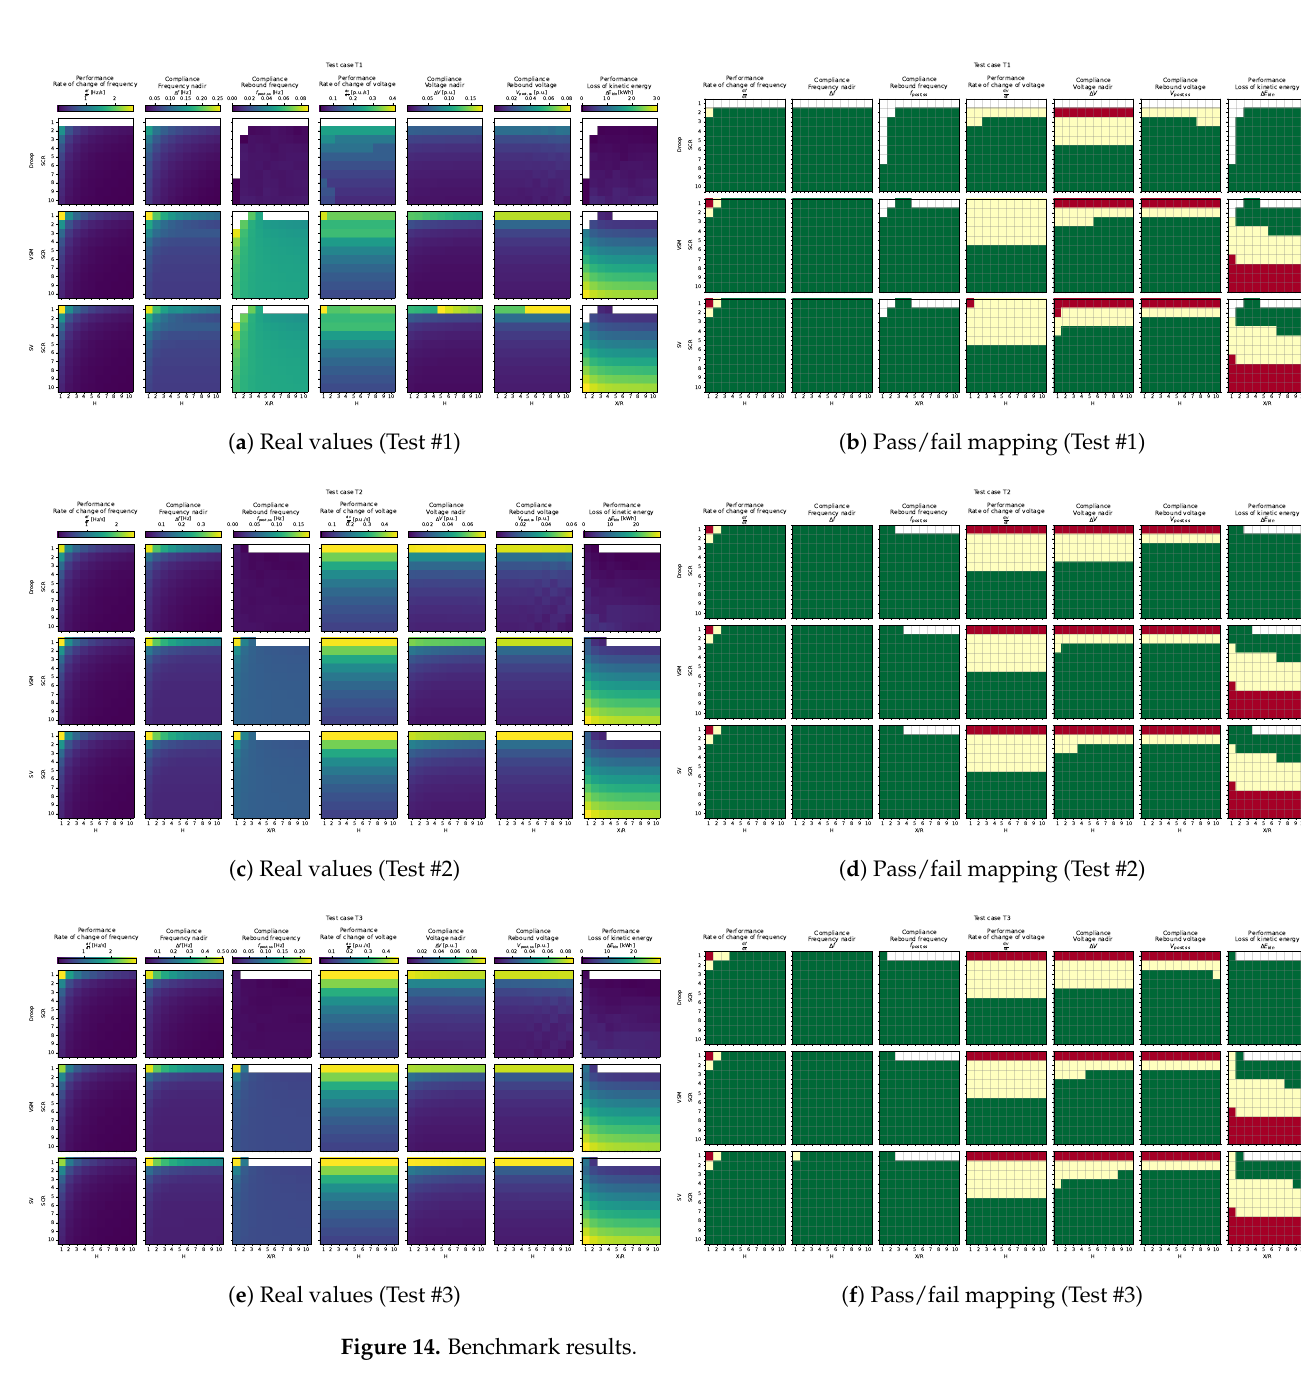
Figure 14. Benchmark